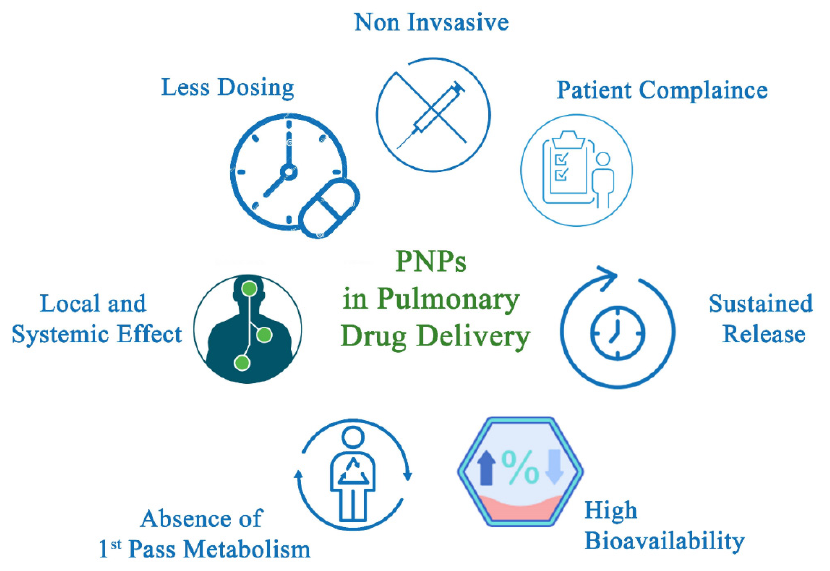
Figure 1. Advantages of PNPs in Pulmonary Drug Delivery Systems.